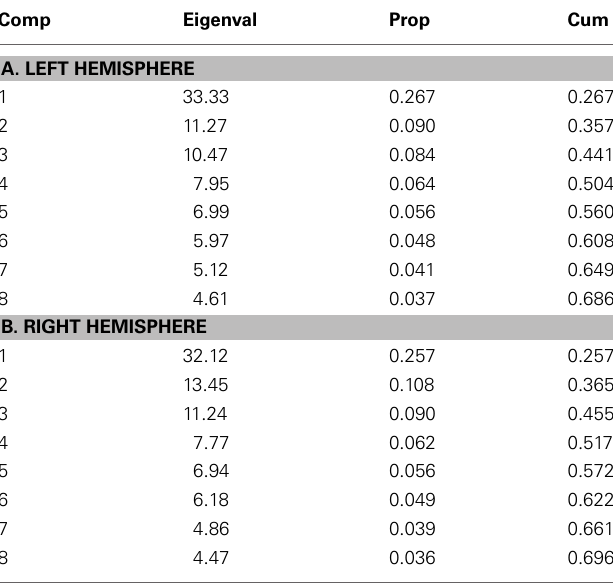
FIGURE 2 | Distributions of the estimated daily practice times of both musician groups. M1 musicians had a significantly longer practicing time per day ( t -test of the means: p = 0 .